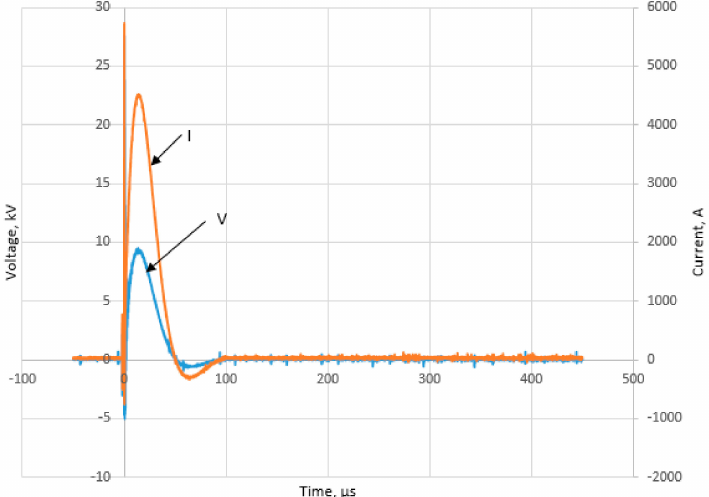
Figure 8. Voltage and current traces of positive polarity for electrodes installed at site 4 at a charging voltage of 30